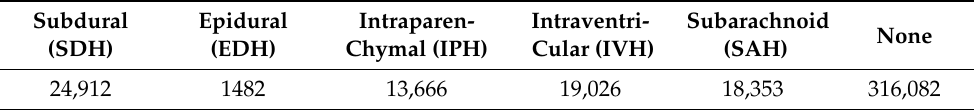
Table 1. Class distribution within the